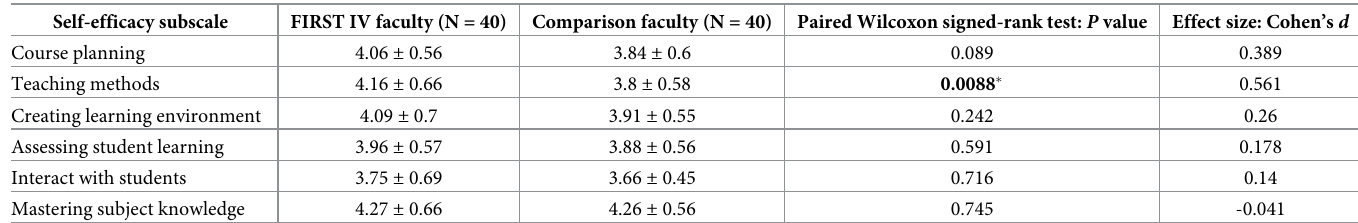
Table 3. Faculty subscale scores (1–5) for the self-efficacy instrument [33]. Reported values for faculty are the mean and standard deviation within a group. Self-efficacy subscale